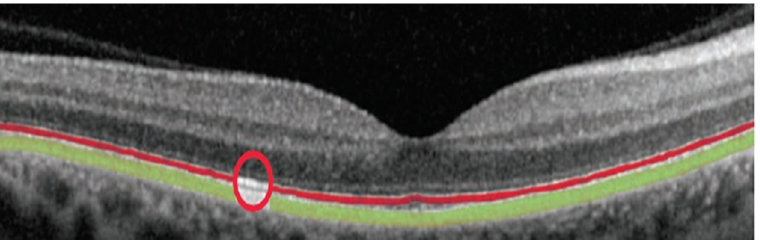
Figure 4. Outer retinal layer (red—photoreceptor, green—RPE, red circle—junction of photoreceptor). PV is the outermost layer of the retina that prevents the retina from exposure to vitreous liquid. The green line in Figure 5 shows the RNFL, and the red line shows the posterior vitreous layer. The nasal side of the image can be identified from the thickness of the RNFL, where a thicker RNFL is seen towards the nasal area, and a thinner RNFL is seen towards the temporal region.